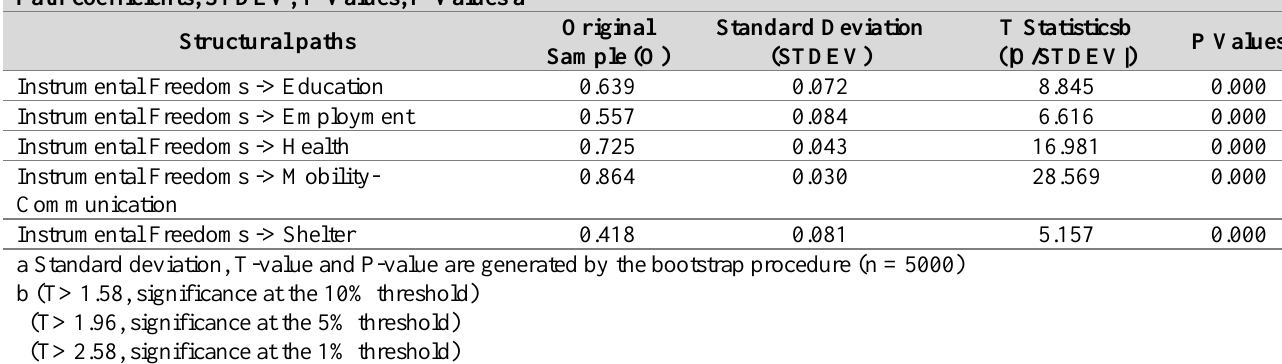
Relevance and significance of the structural model path coefficients Path coefficients, STDEV, T-Values, P-Values a